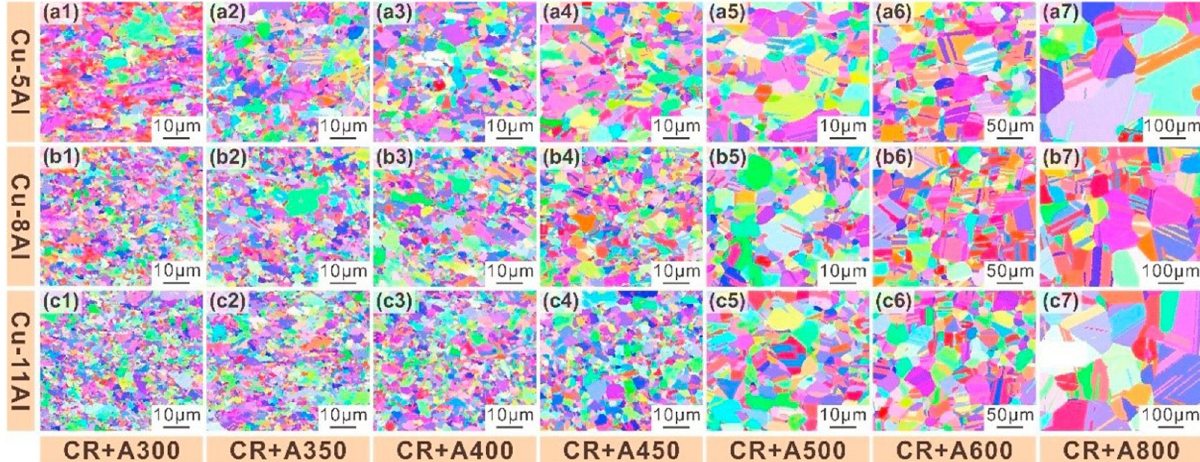
Figure 10: The microstructure of Cu – Al alloy at di ff erent annealing temperatures increases from left to right: ( a1 – 7 ) Cu – 5Al alloys, ( b1 – 7 ) Cu – 8Al alloys, and ( c1 – 7 ) Cu – 11Al alloys [ 142 ]